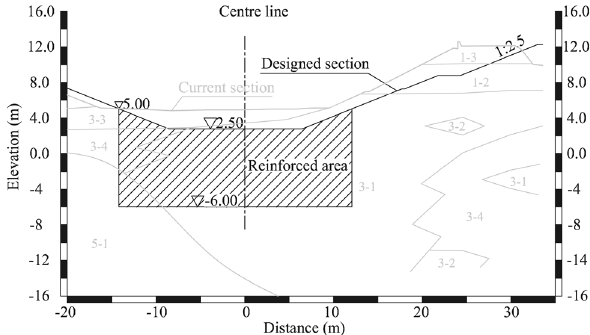
Figure 1. The representative cross-section of the test site on the Jiuxiang River.